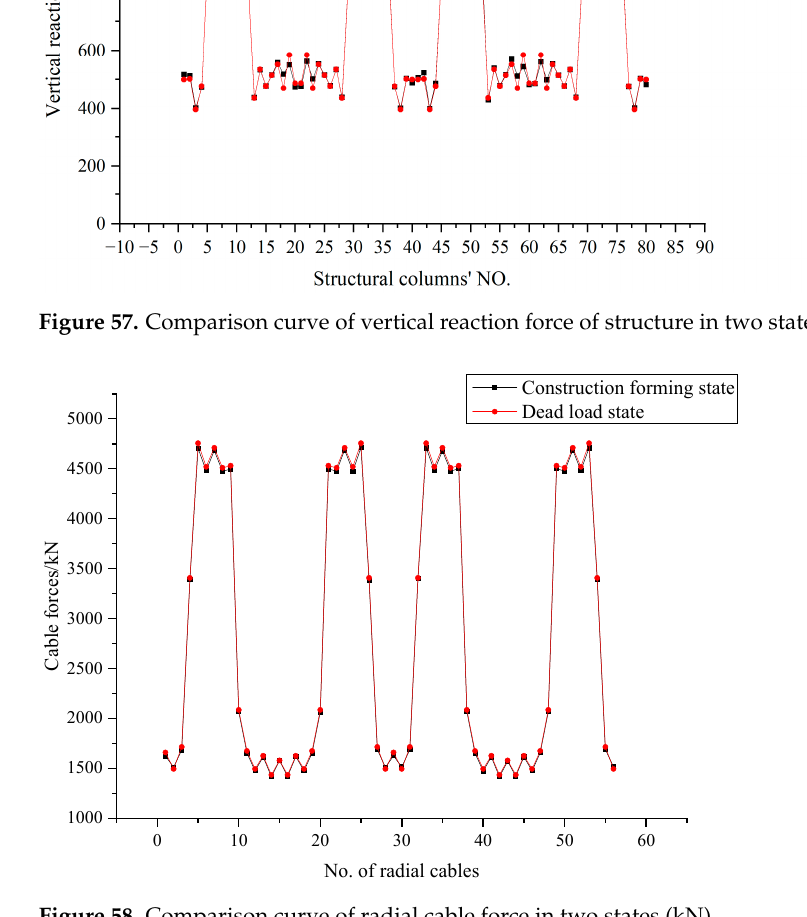
Figure 58. Comparison curve of radial cable force in two states (kN).